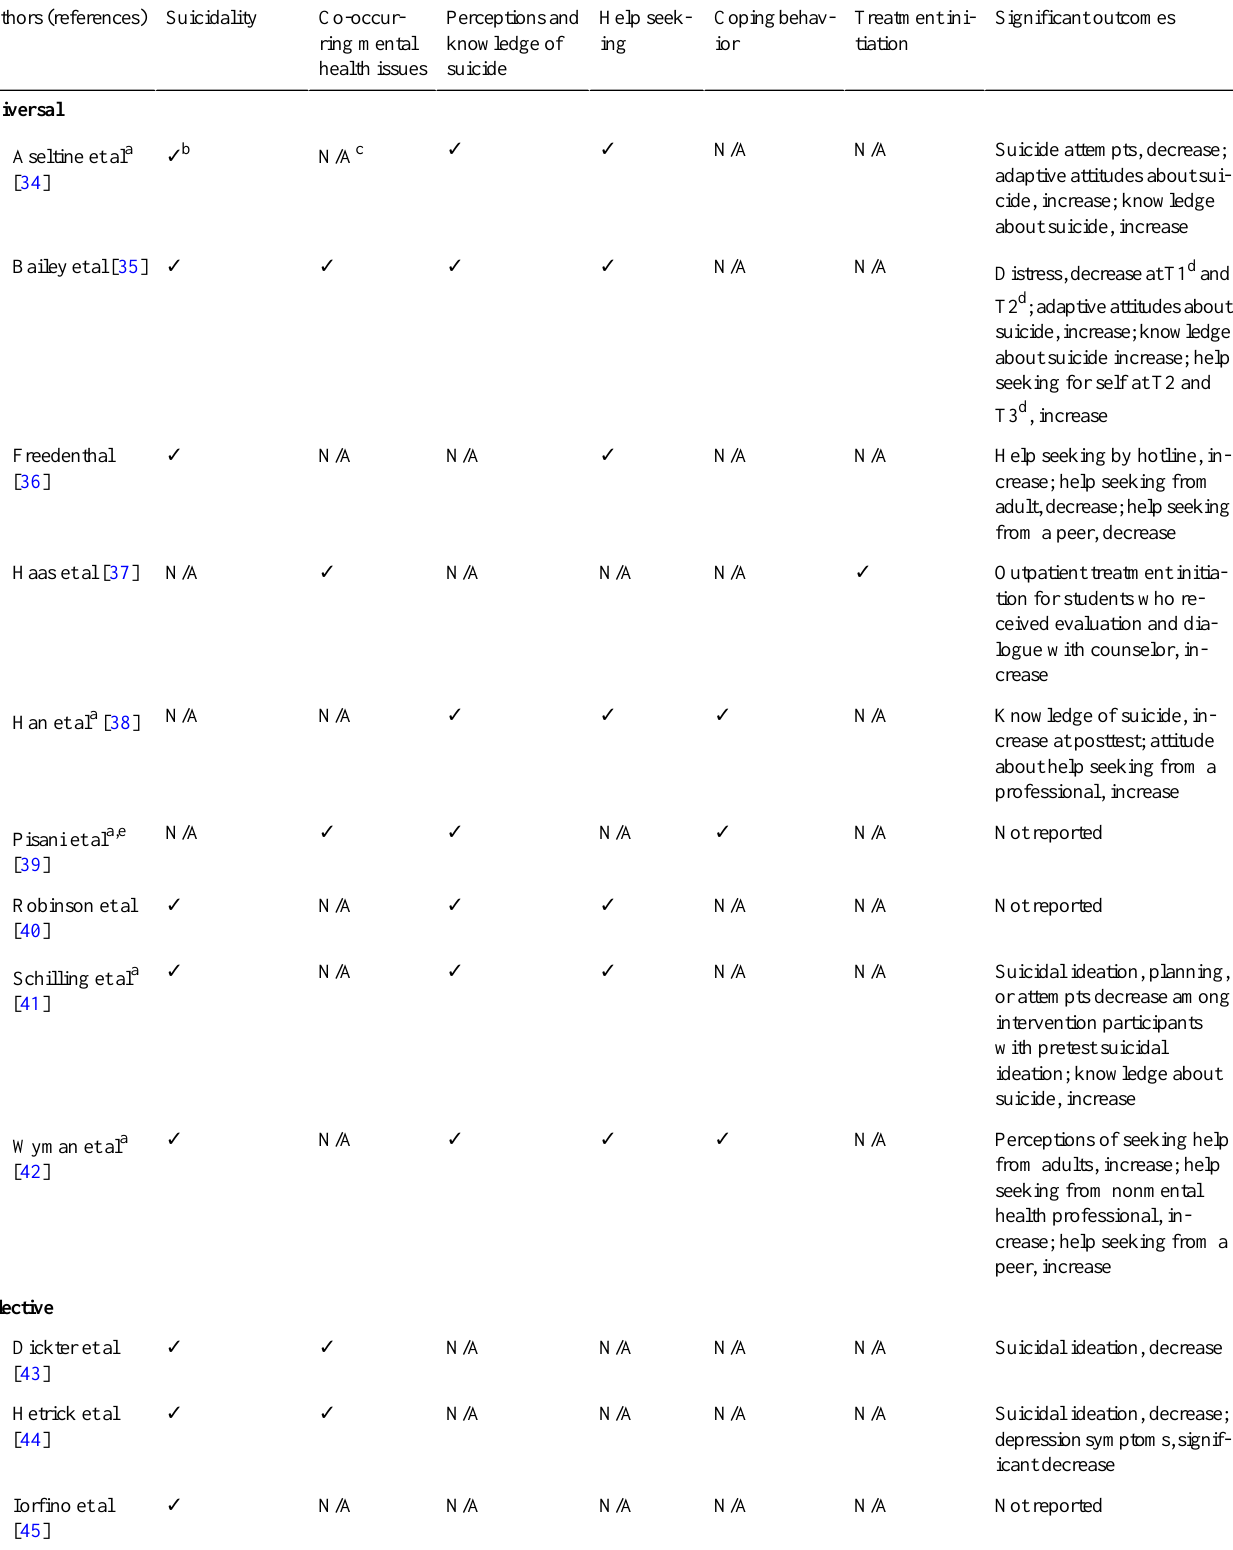
Table 4. Measured and significant intervention